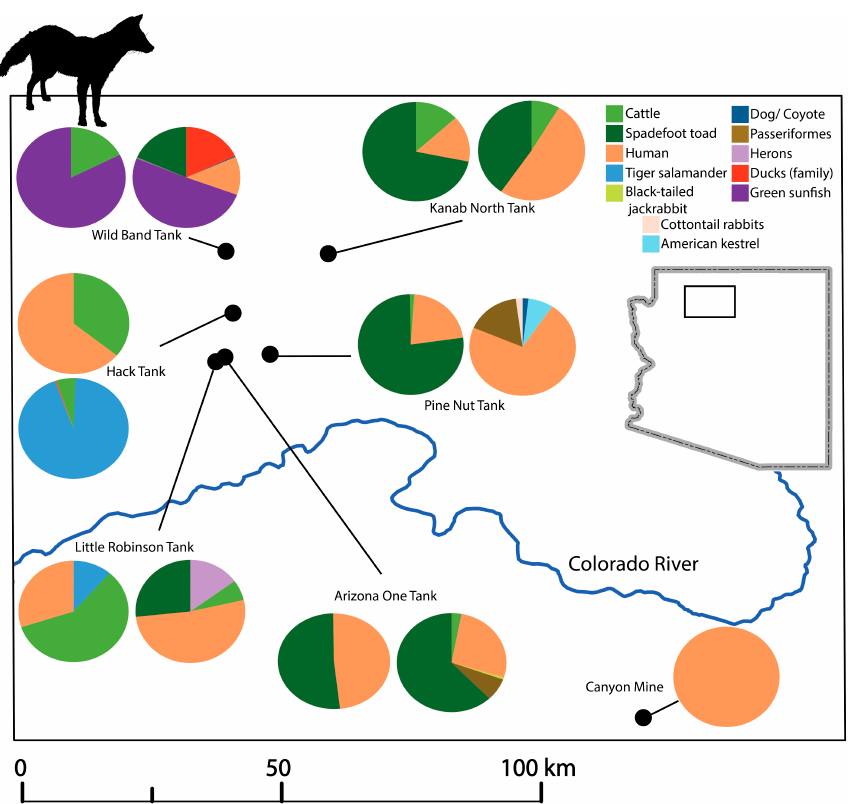
Figure 2. Pie charts show percentage of total reads per site for each taxa for the 12S assay. The left or top pie chart is the earlier date sampled, and the right or bottom chart is the later date sampled for each site. Figure only shows taxa that are 0.3% or greater of the total read counts for that site. See Tables S2 and S3 for all taxa reads per site. (Fox image: Brian Gratwicke—photo; T. Michael Keesey—vectorization; https://creativecommons.org/licenses/by-sa/3.0/).